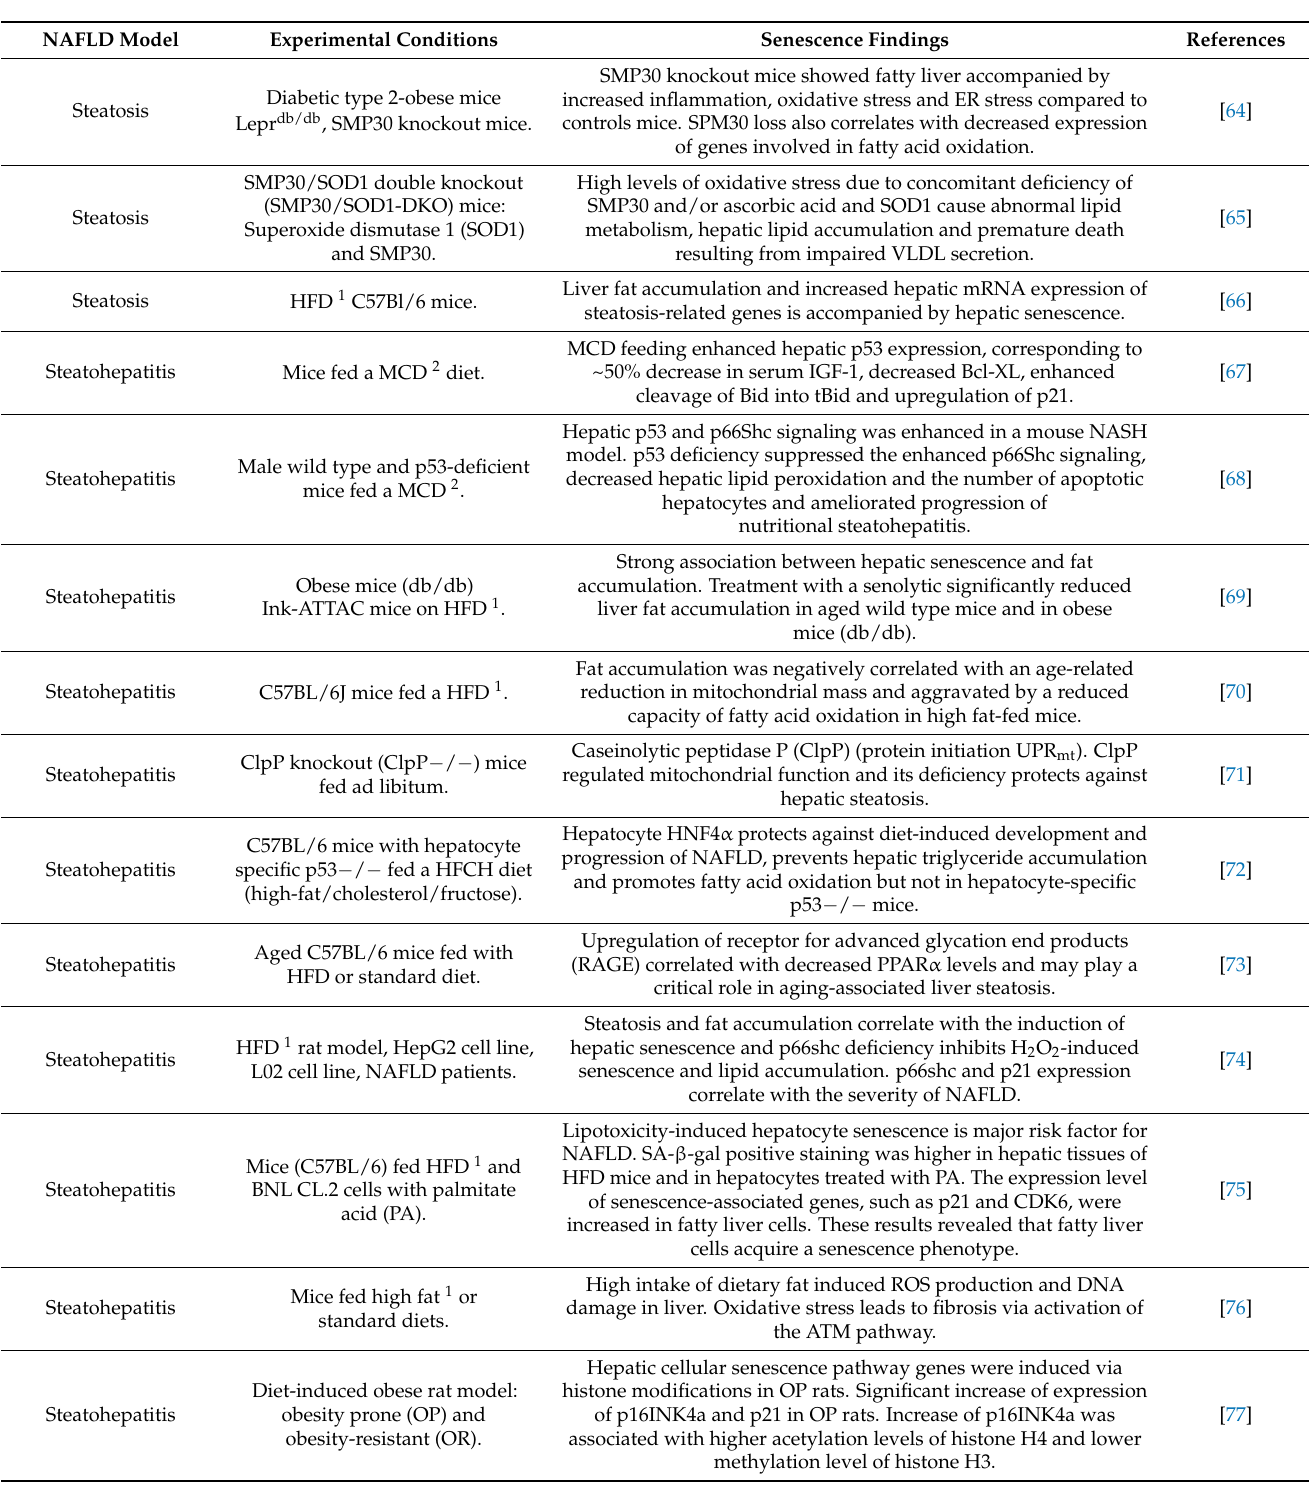
Table 2. Association between senescence and NAFLD in in vivo